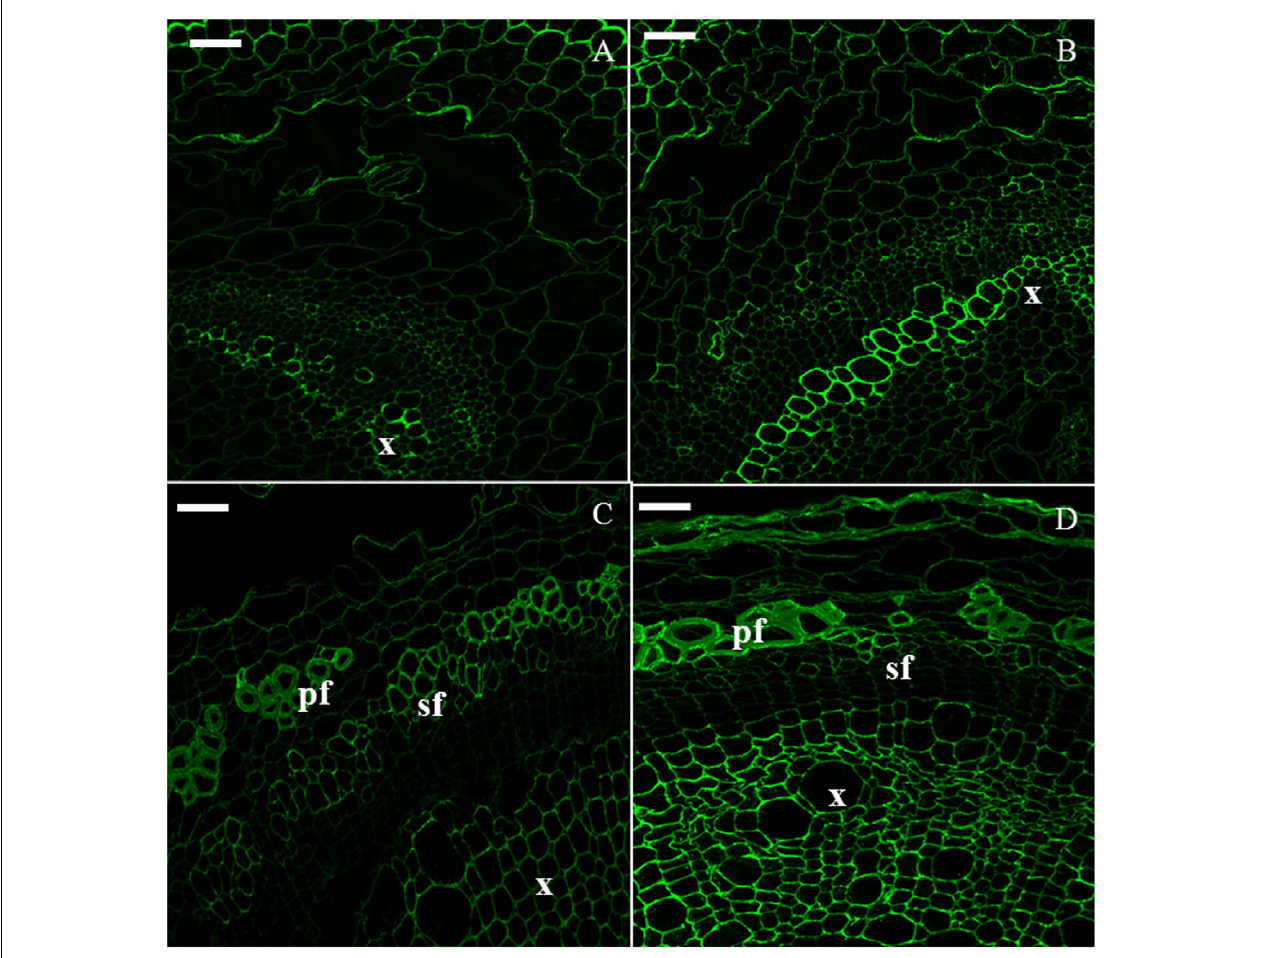
FIGURE 5 | Immunodetection of the CBM3a epitope specific for crystalline cellulose. H6 ( A , top left), H9 ( B , top right), H15 ( C, bottom left), H20 ( D , bottom right). pf, primary bast fiber; sf, secondary bast fiber; x, xylem. Scale bar: 50 µ m.